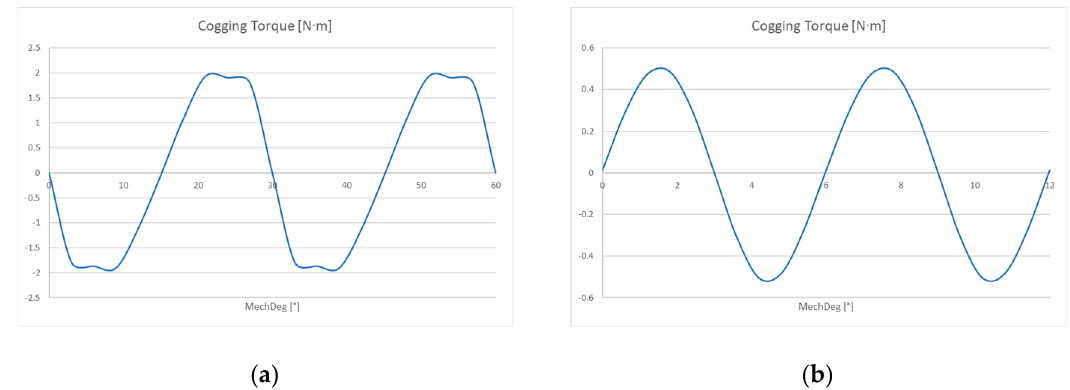
Figure 2. Cogging torque for a 1.4 kW machine with: ( a ) Q = 12, p = 4, τ = 30°; ( b ) Q = 12, p = 10, τ = 6°.